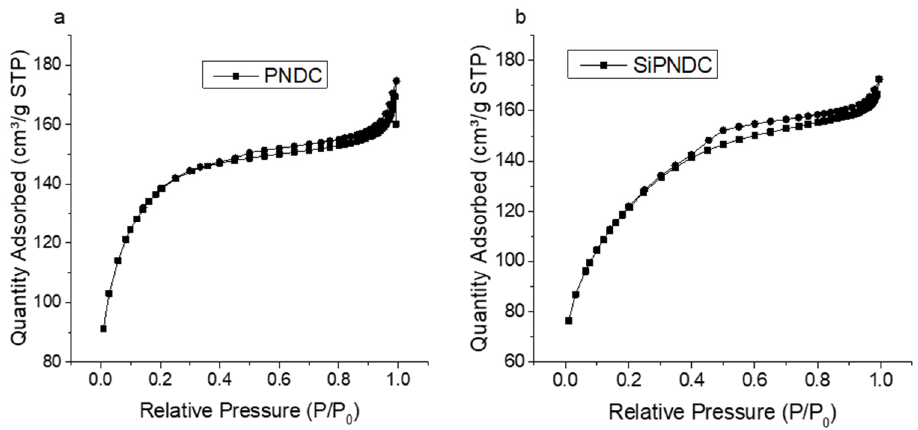
Figure 2. Nitrogen adsorption and desorption curves for ( a ) PNDC and ( b ) SiPNDC. The BET surface areas of the two samples are remarkably similar (437 and 426 m 2 g − 1 for Table 2. Surface area and porosity analysis of doped carbon materials . PNDC and SiPNDC, respectively), indicating that the major constituent, molasses, is